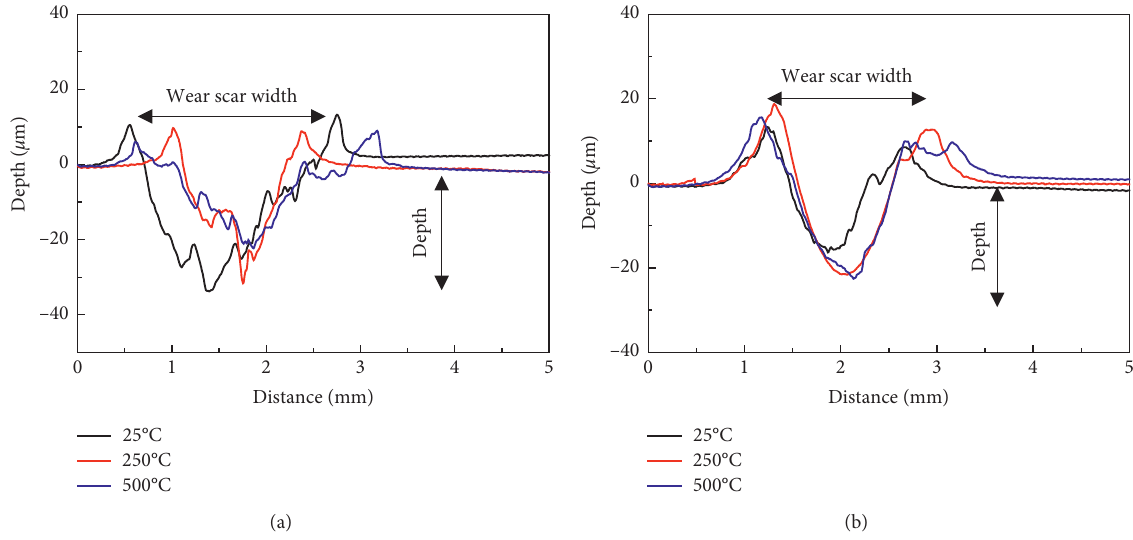
Figure 7: Two-dimensional contour of the wear scar of Inconel 625 superalloy by (a) GCr15 and (b) Si and a load of 15N.